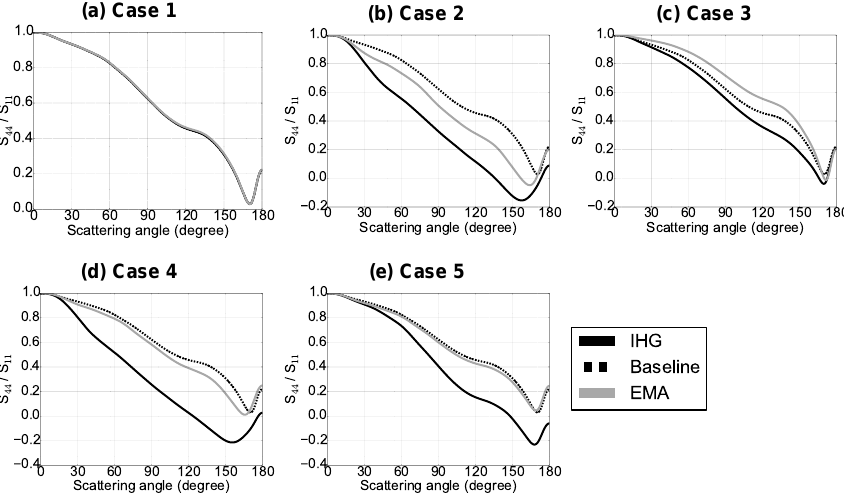
Figure 9. S 44 /S 11 values for the inhomogeneous (IHG), the baseline, and the homogeneous (EMA) versions of all five of the internal structure cases as a function of the scattering